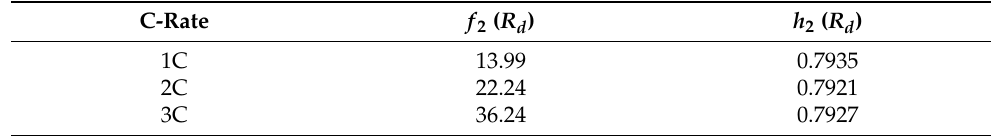
Figure 7. Fitting curves of capacity degradation at different temperatures. Table 2. Identification parameters under the degenerating